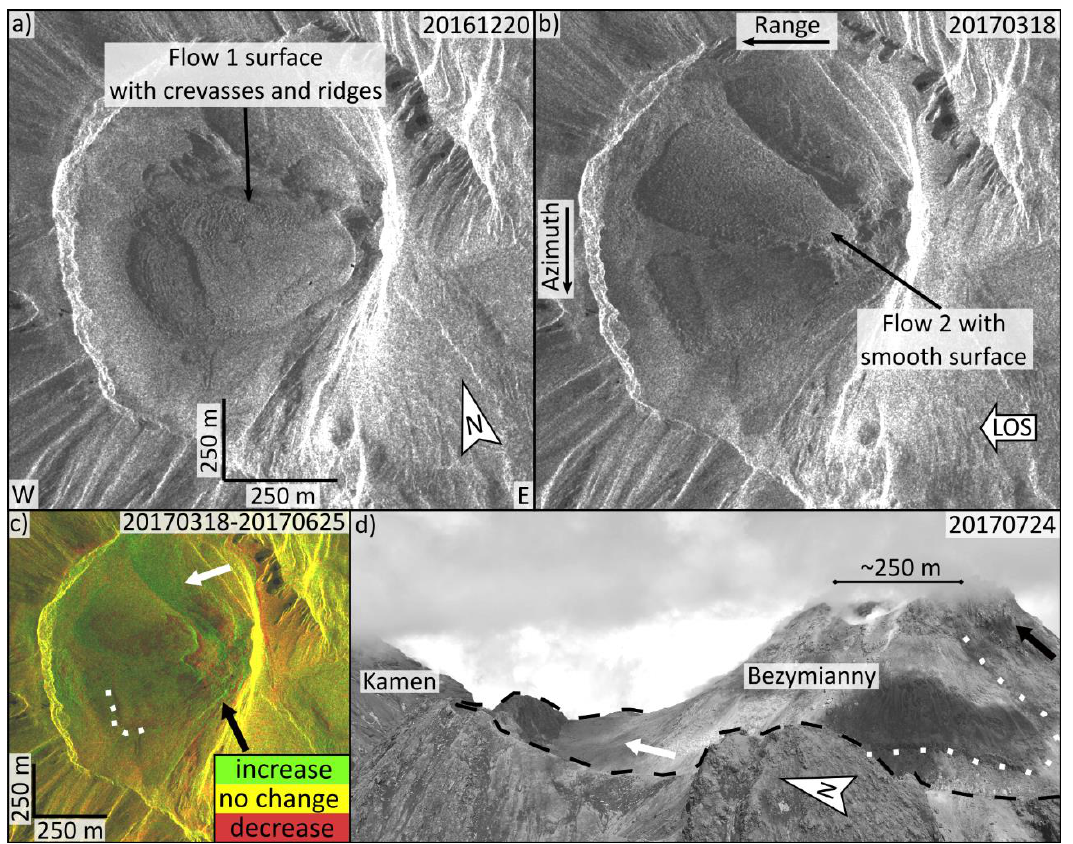
Figure 6. Topographic changes at Bezymianny between December 2016 and June 2017. ( a , b ) show amplitude images of Bezymianny after the 5 December 2016 and 9 March 2017 eruptions, both marked by large lava flows. ( c ) Amplitude change di ff erence map and ( d ) aerial image after the 16 June 2017 eruption. White and black arrows ( c , d ) indicate deposition of pyroclastic deposits and an extrusive body, respectively. Both, the pyroclastic deposits and the extrusive body are indicated by reflectivity increases in ( c ) (green colouring), whereby the extrusive body is barely perceptible.